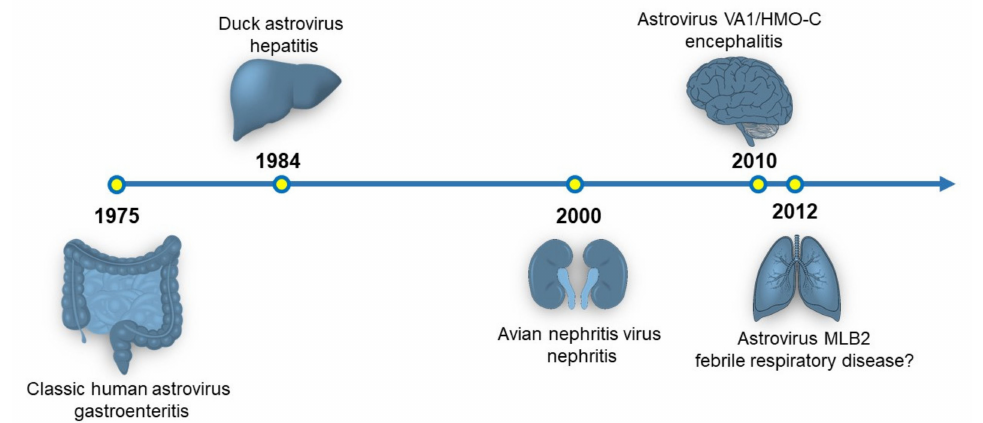
Figure 1. Timeline of the organ systems associated with astrovirus disease. The originally identi- fied astrovirus strain and disease association are shown. Currently, there is a hypothesized link between astrovirus infection and respiratory disease, but no experimental data exists supporting this